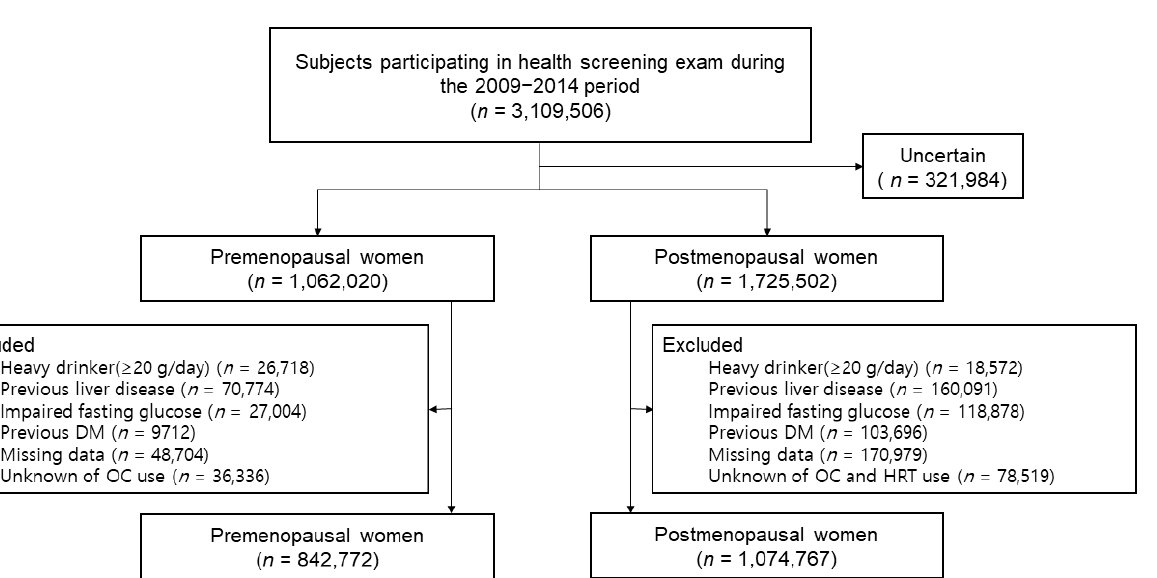
Figure 1. Flow chart of the study population.